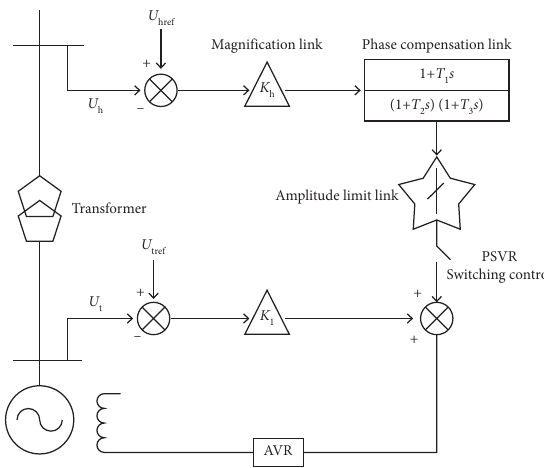
Figure 1: The mathematical model of the power system control